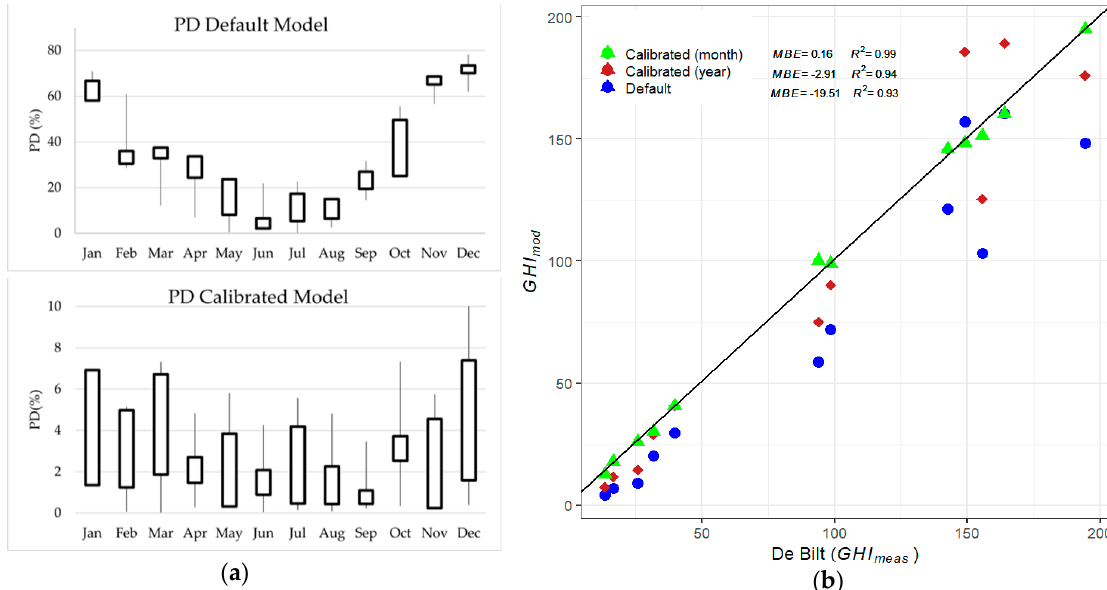
Figure 6. ( a ) Range of PD for the default model and the calibrated model for all the 10 years and ( b ) Scatterplot of default and best fit (calibrated values) per month and year vs. the measured values from de Bilt for 2020. The difference in PD between the default and the calibrated model is huge (Figure